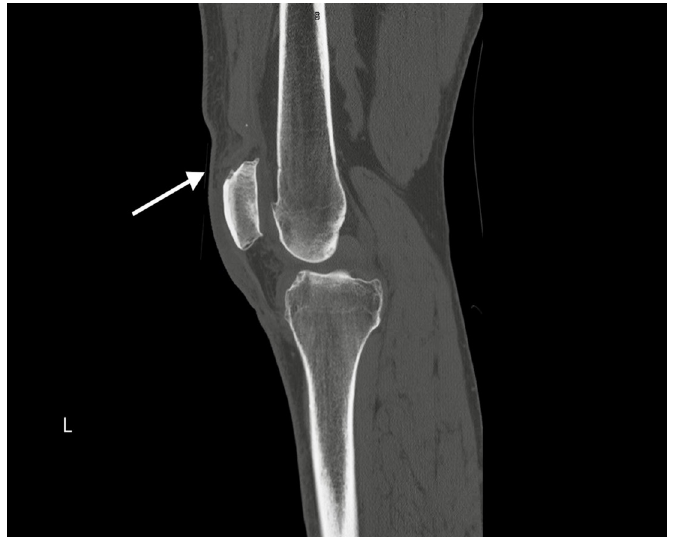
Image 3. Computed tomography of left knee demonstrating near- complete tear of quadriceps tendon with retraction of the central portion of the tendon